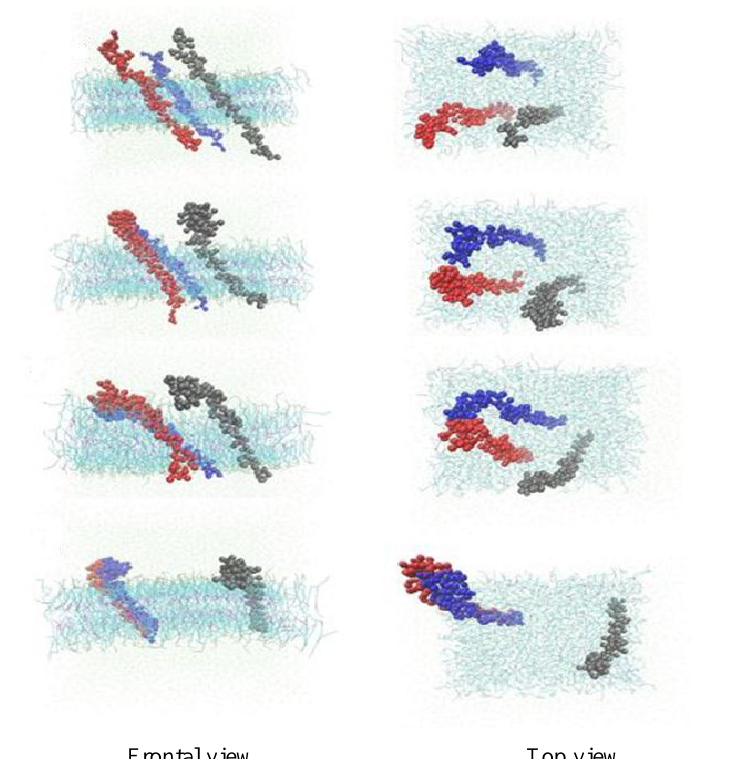
Figure 9. Simulation stages of β-subunit